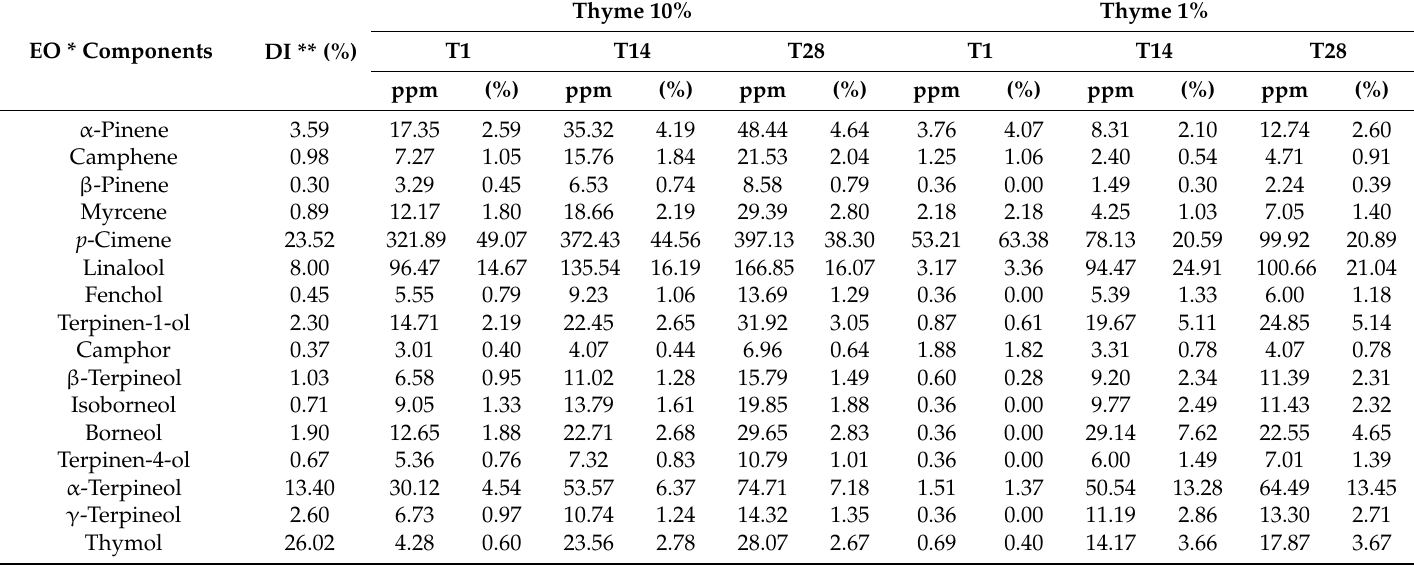
Table 2. Thyme essential oil composition and volatilized compounds in storage cabinet at 1, 14 and 28